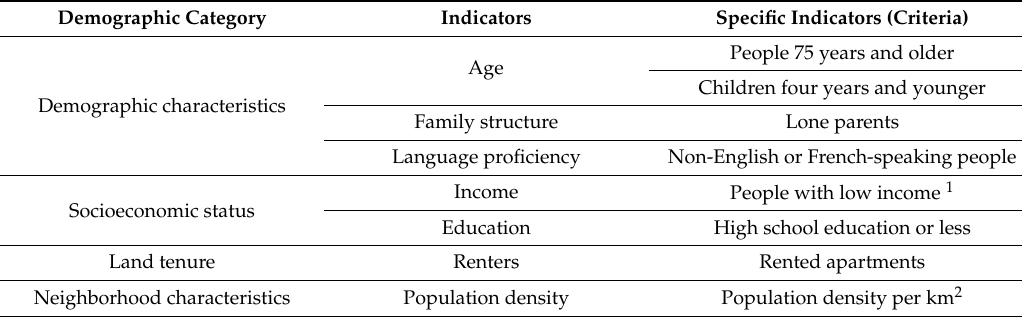
Table 3. Criteria for social